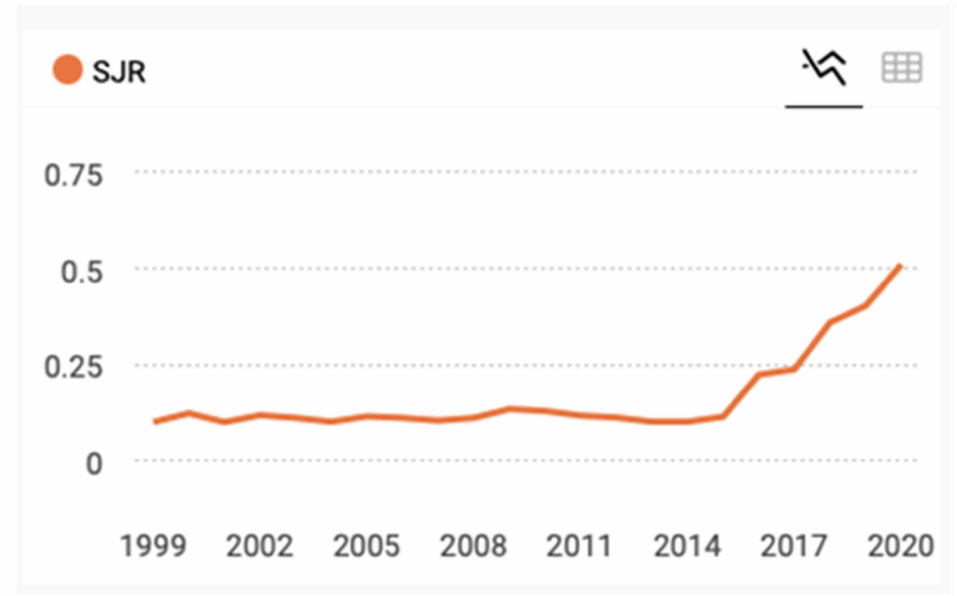
Figure 5. The analysed journal SJR values 1999–2020, where the increasing trend also follows a larger number of published papers per year.